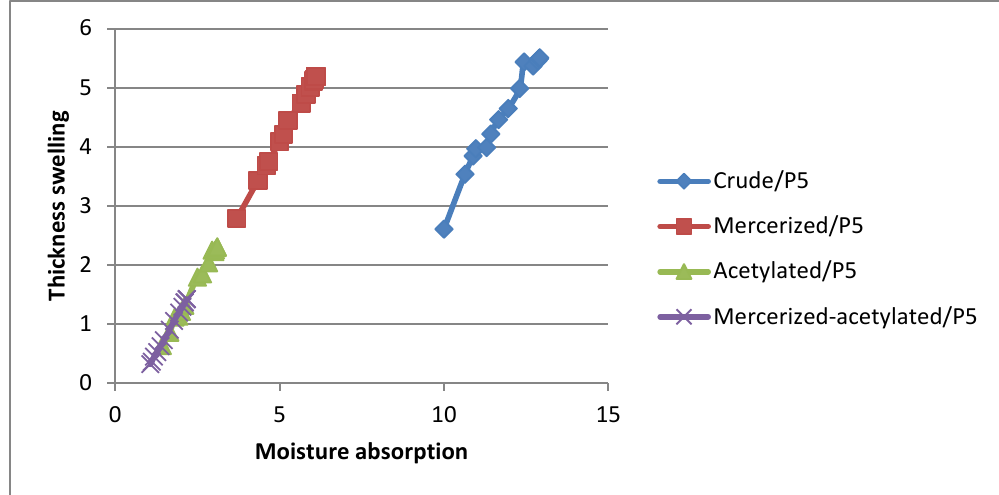
Fig. 17. Moisture absorption versus thickness swelling for P5 fibre contents among various fibre